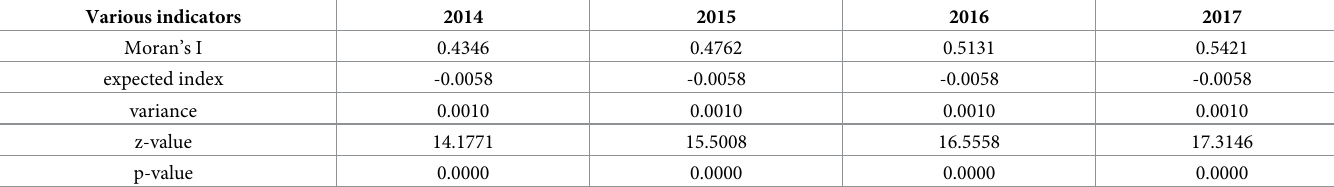
Table 4. Statistical table of spatial autocorrelation analysis of residential land prices in Beijing-Tianjin-Hebei from 2014 to 2017. Various